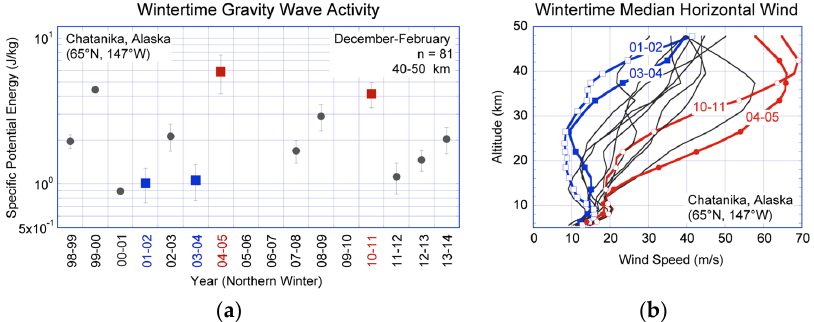
Figure 14. ( a ) Wintertime averaged values of specific potential energy plotted as a function of year. Values for 2005–2006, 2006–2007 and 2009–2010 are omitted because no LiDAR measurements were made during those winters. ( b ) Wintertime median horizontal wind speed over Poker Flat Research Range. Disturbed winters with low wind speeds are plotted in blue. Quiet winters with high wind speeds are plotted in red. The corresponding gravity wave energies are also plotted in blue and red.